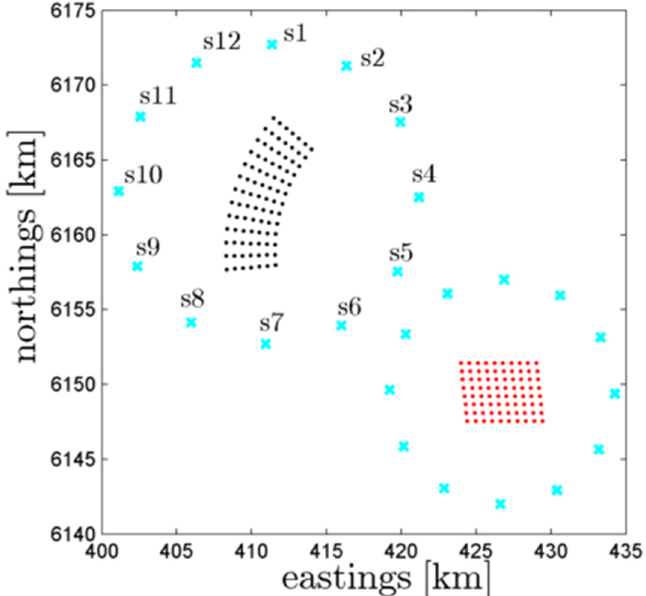
Figure 4. Horns Rev 1 and 2 wind farms in red and black markers,